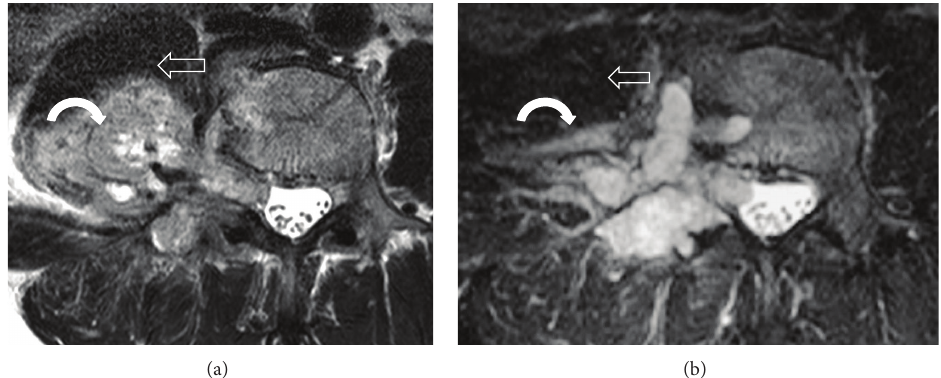
Figure 7: Comparison of the preoperative (a) and postoperative (b) T2W MR image at the L4 vertebral body level, demonstrating a reduction in tumour size (curved arrow) after partial tumour resection. In particular, the invasion into the psoas muscle (open arrow) is